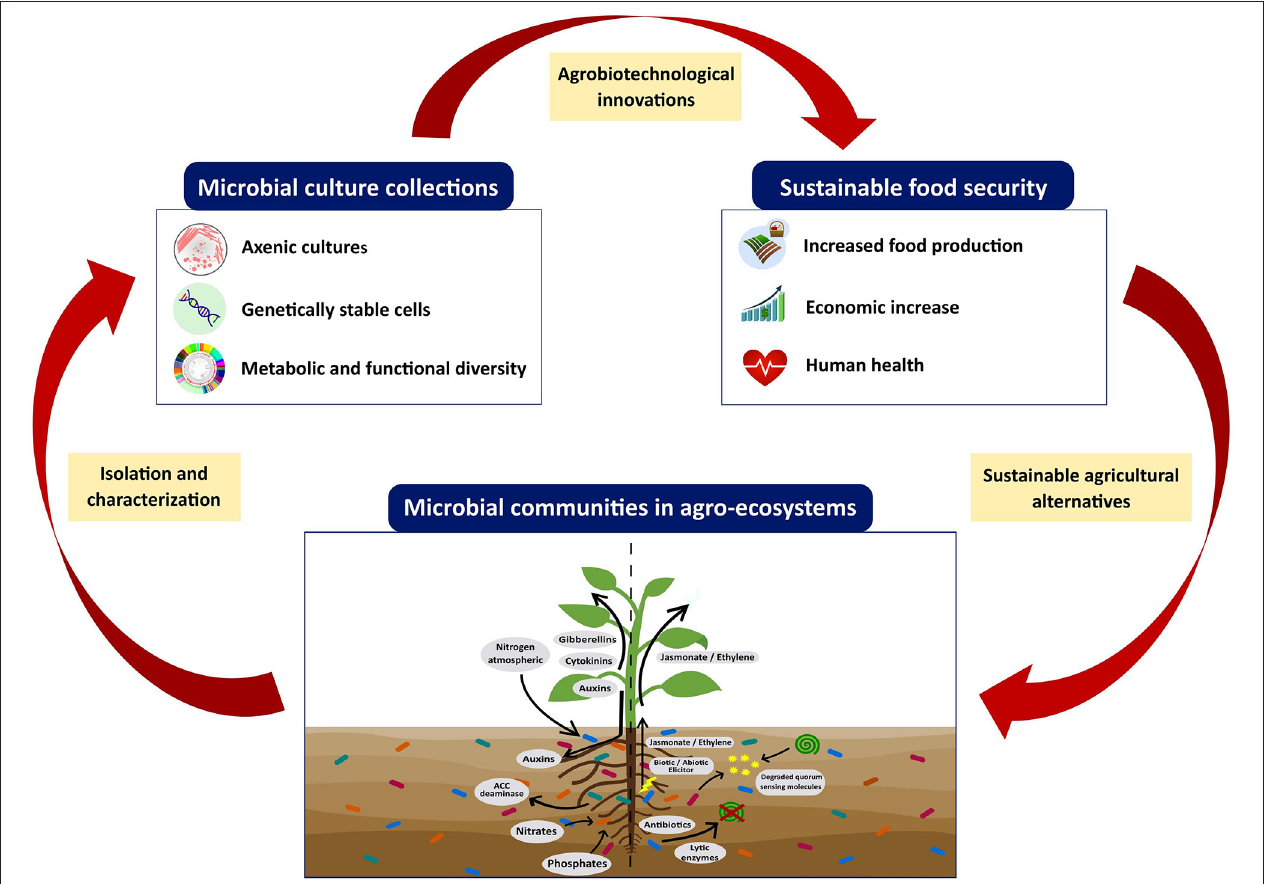
FIGURE 3 | The role of microbial culture collections on global food security providing plant growth-promoting microorganisms for the innovation of sustainable